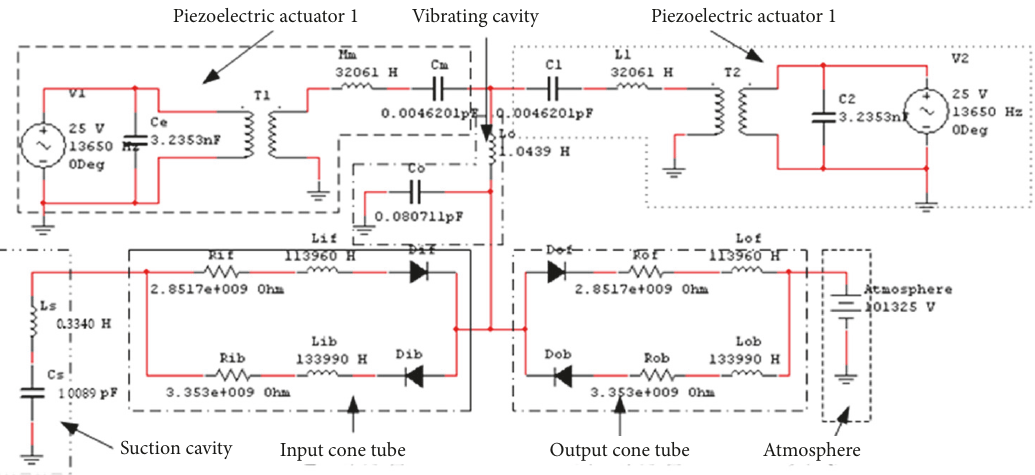
Figure 16: Equivalent electrical network model of the micropump suction cup.